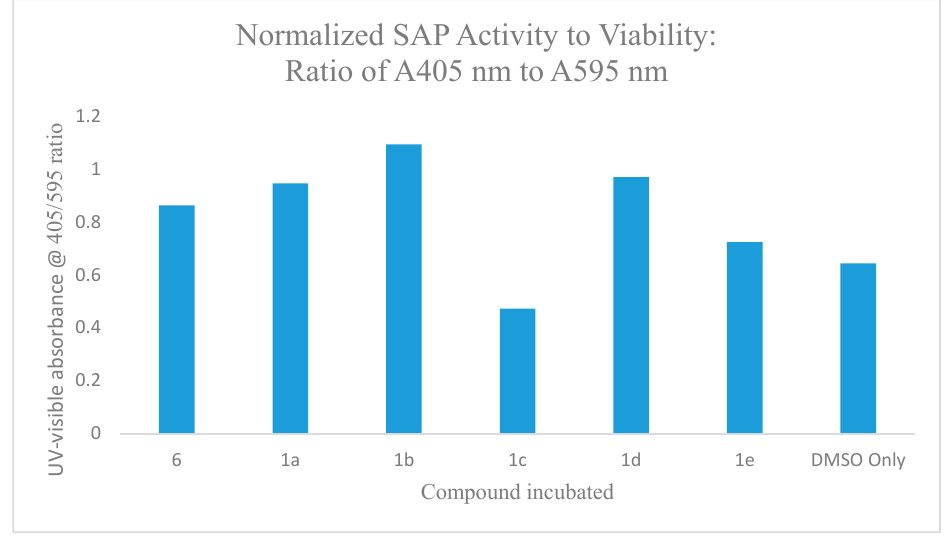
Figure 6. Normalized secreted acid phosphatase (SAP) assay absorbance to MTT absorbance per condition.